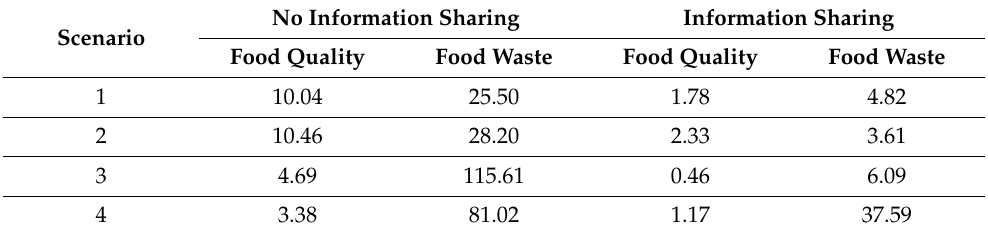
Table 5. MAPE by main model scenarios, food quality, and waste of actual and